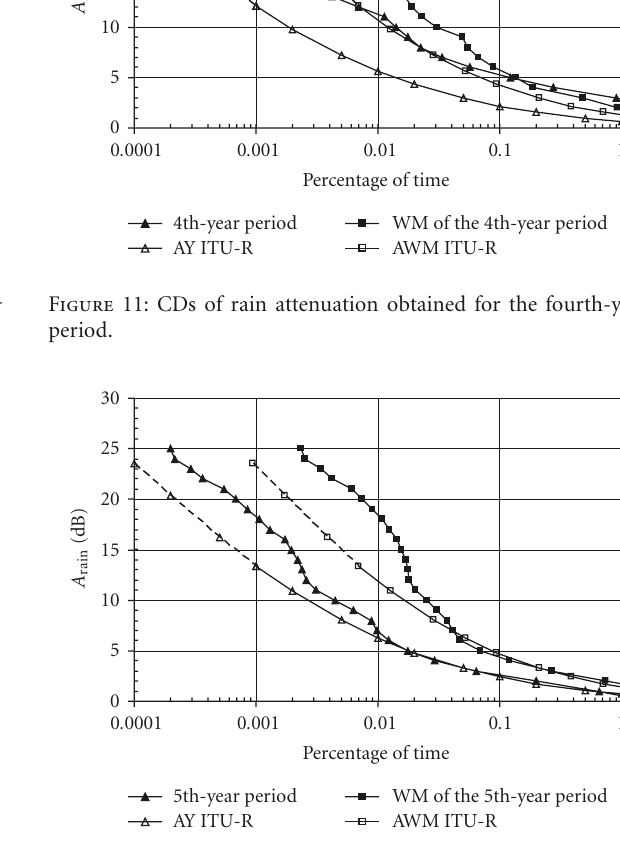
Figure 10: CDs of rain attenuation obtained for the third-year pe- riod.